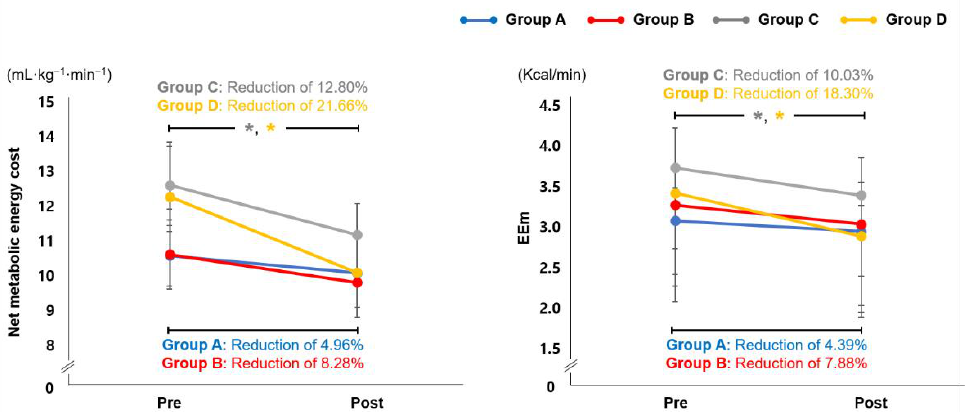
Figure 3. Cardiopulmonary Metabolic Energy Cost. Changes in cardiopulmonary metabolic energy cost at the pre and post time points in groups A, B, C, and D. Group A: overground walking without an EX1, group B: overground walking using the resistance mode of EX1, group C: stair ascent using the assistance mode of EX1, group D: inclined treadmill walking using the assistance mode of EX1. * p < 0.05 compared with pre, paired t-test. EEm, energy expenditure measurement.